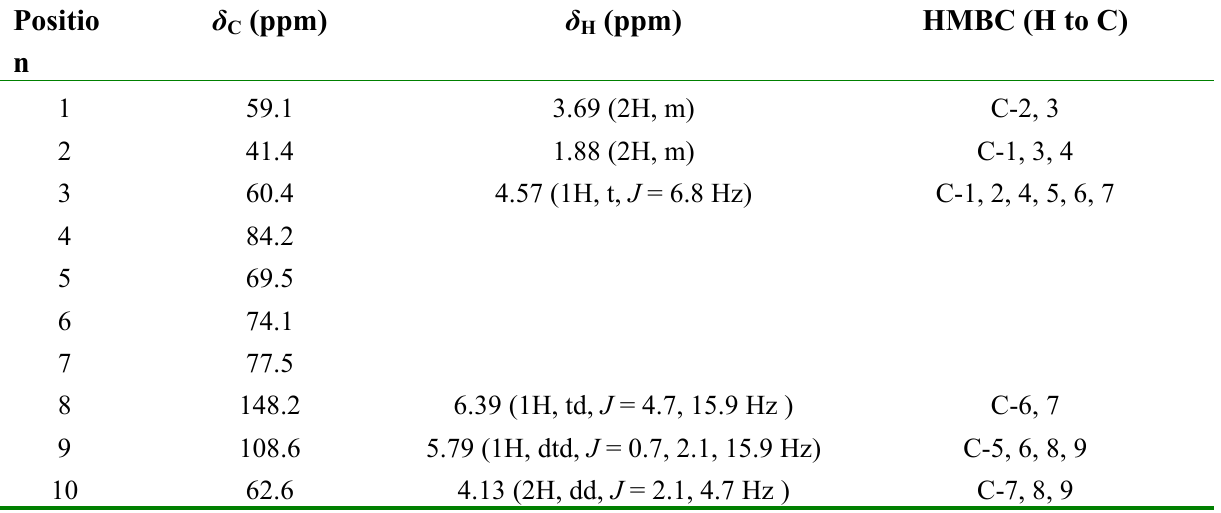
OD) and 1 H-NMR (400 MHz) data of compound 8 . 3